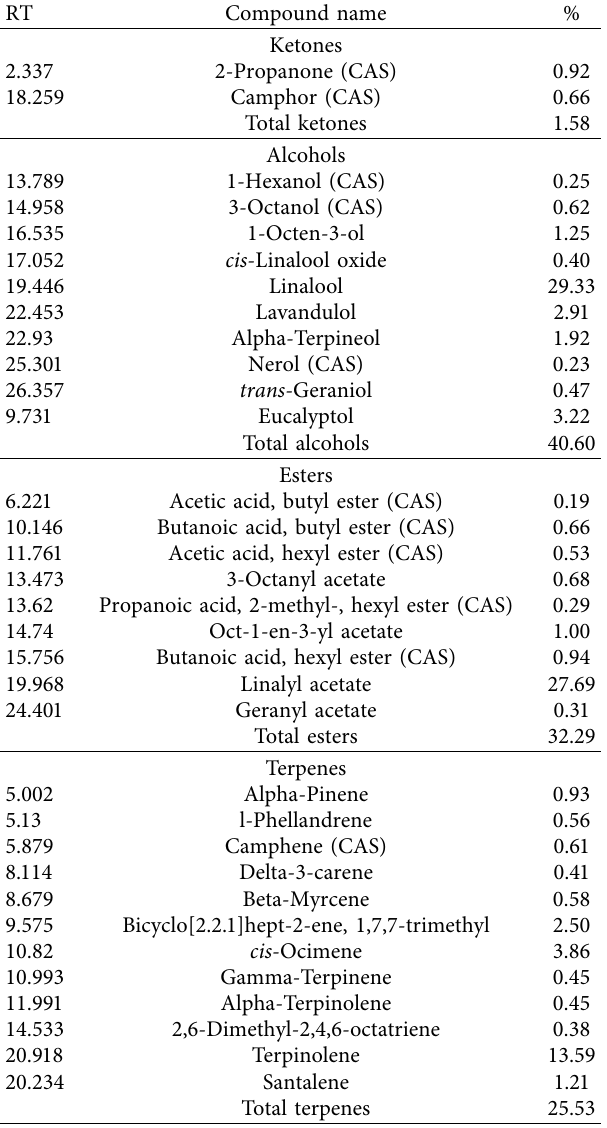
Table 2: Volatile compounds of lavender